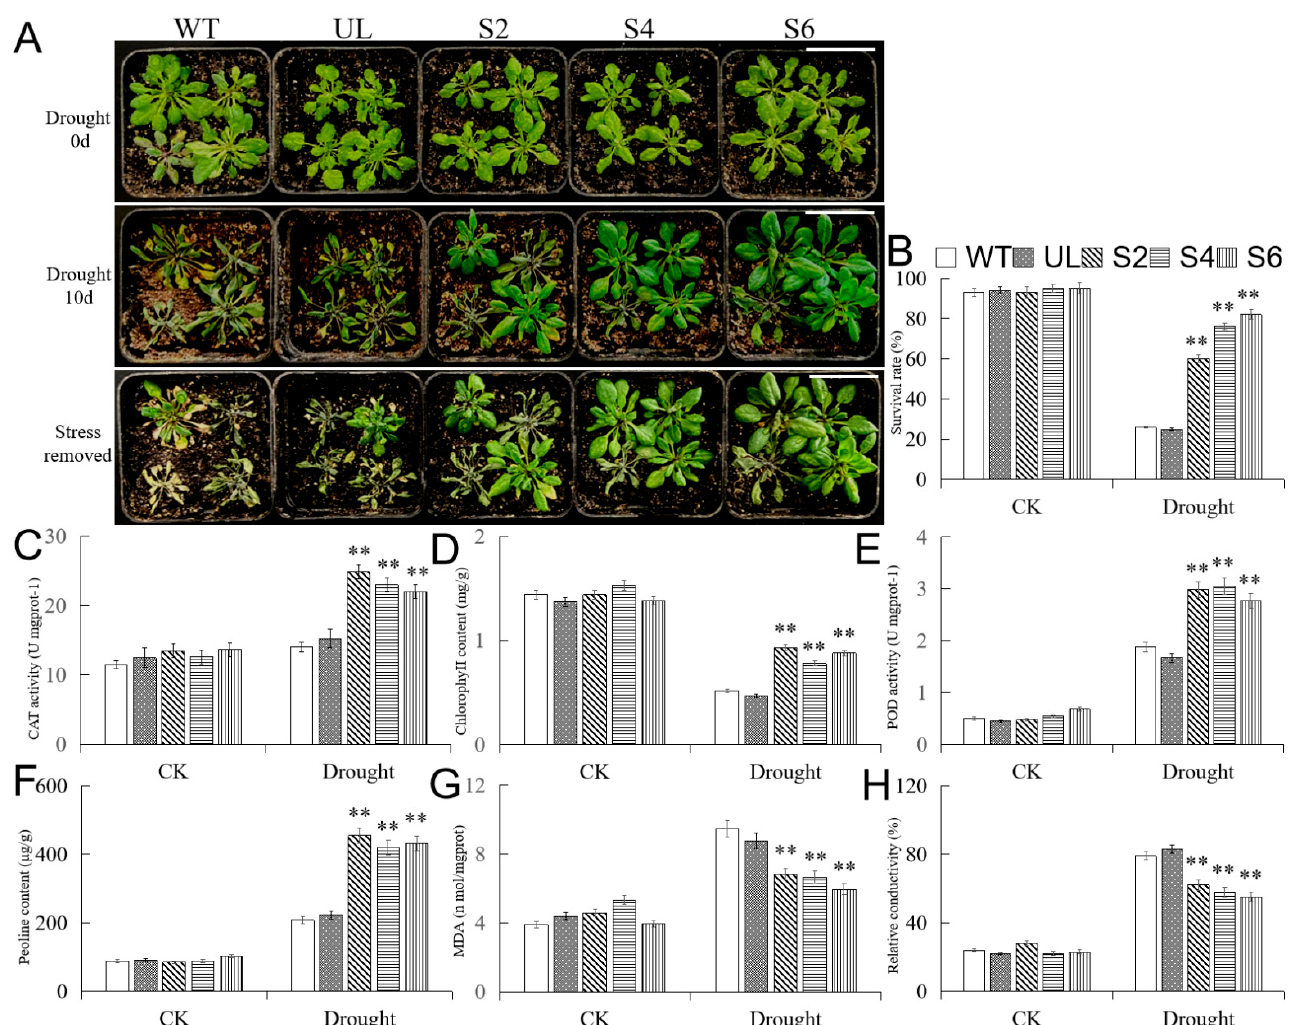
Figure 7. Overexpression of MbMYB108 in A. thaliana improved drought tolerance. ( A ) Phenotypic map of each line (WT, UL, S2, S4, and S6) of A. thaliana under CK (Drought 0 days), drought stress (Drought 10 days), and recovery conditions (stress removed). Scale bar corresponds to 4 cm. ( B ) The survival rates of each line (WT, UL, S2, S4, and S6) of A. thaliana under CK and drought stress. ( C ) Catalase (CAT) activity. ( D ) Chlorophyll content. ( E ) Peroxidase (POD) activity. ( F ) Proline content. ( G ) Malondialdehyde (MDA) content. ( H ) Relative conductivity. Asterisks above the error bars indicate extremely significant differences between transgenic (S2, S4, S6) and WT A. thaliana (** p ≤ 0.01). The level of each index in the WT line was used as a control.